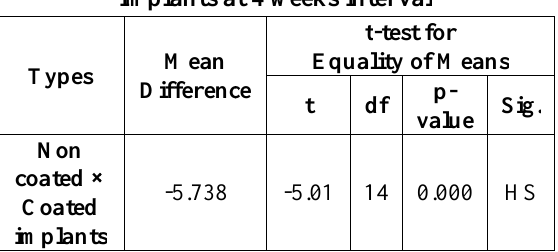
Table 3: t Table 3: t-test for coated and uncoated test for coated and uncoated test for coated and uncoated implants at 4 weeks interval implants at 4 weeks interval implants at 4 weeks interval